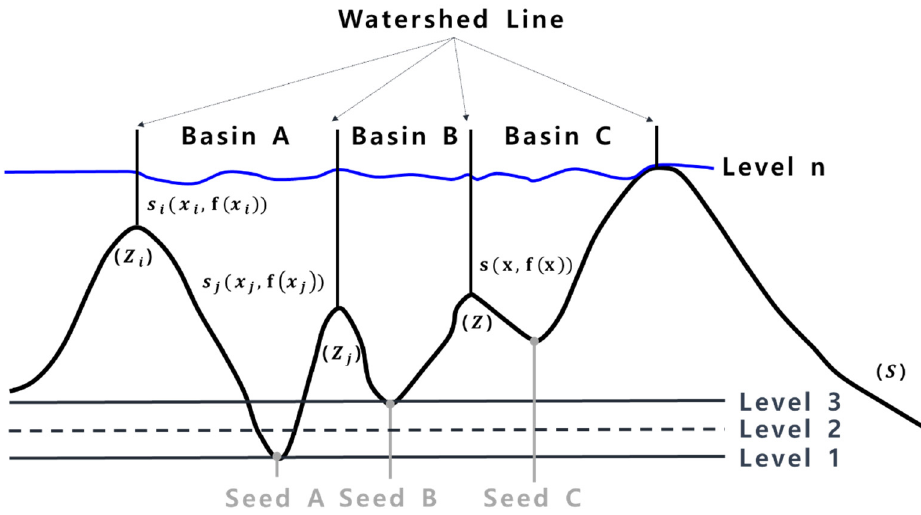
Figure 5. Concept map of the watershed analysis method.